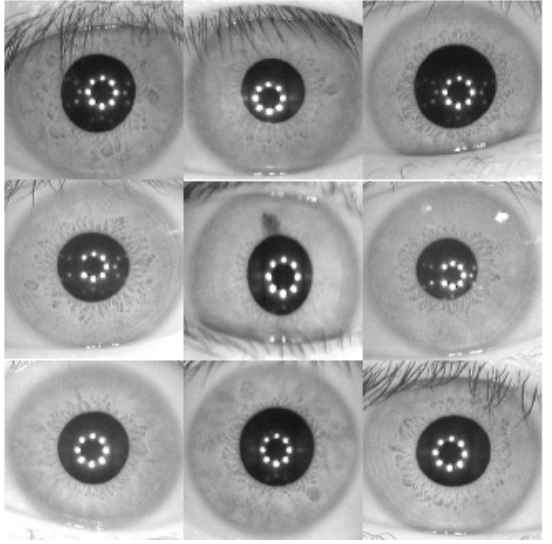
Figure 6. Subset of images from the CASIA Iris dataset used to perform statistical analysis of the proposed ciphering scheme.